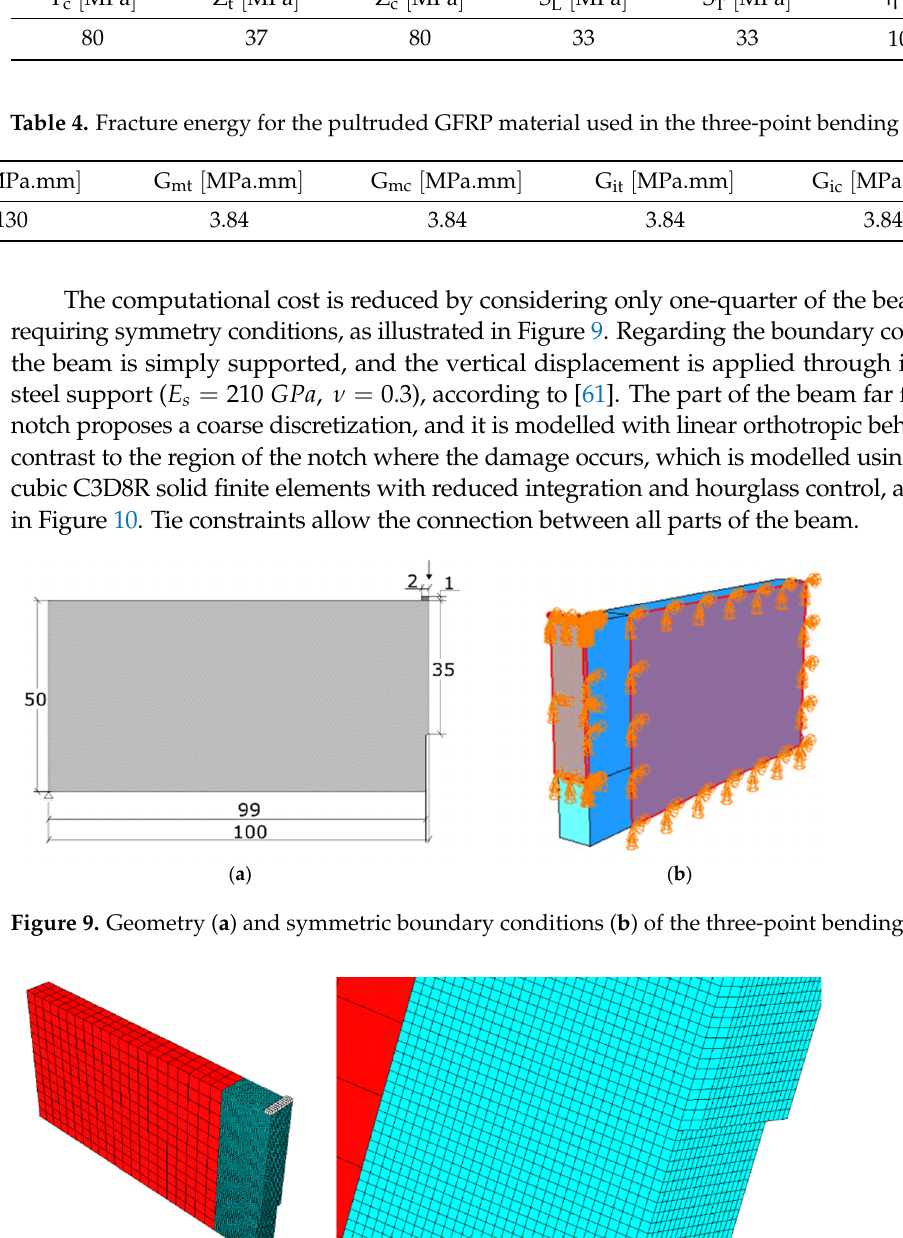
Figure 10. Adopted 3D mesh ( a ) and magnification of the proposed UMAT area ( b ) for the three- point bending beam.